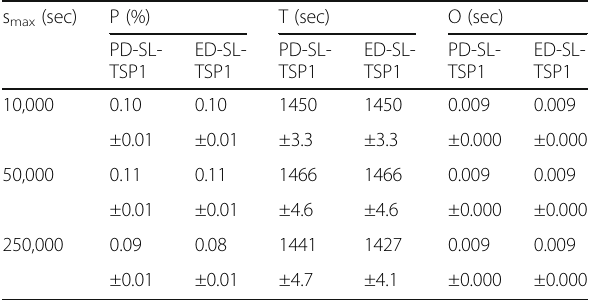
Table 4 LIGO workload: effect of s max on P , T , and